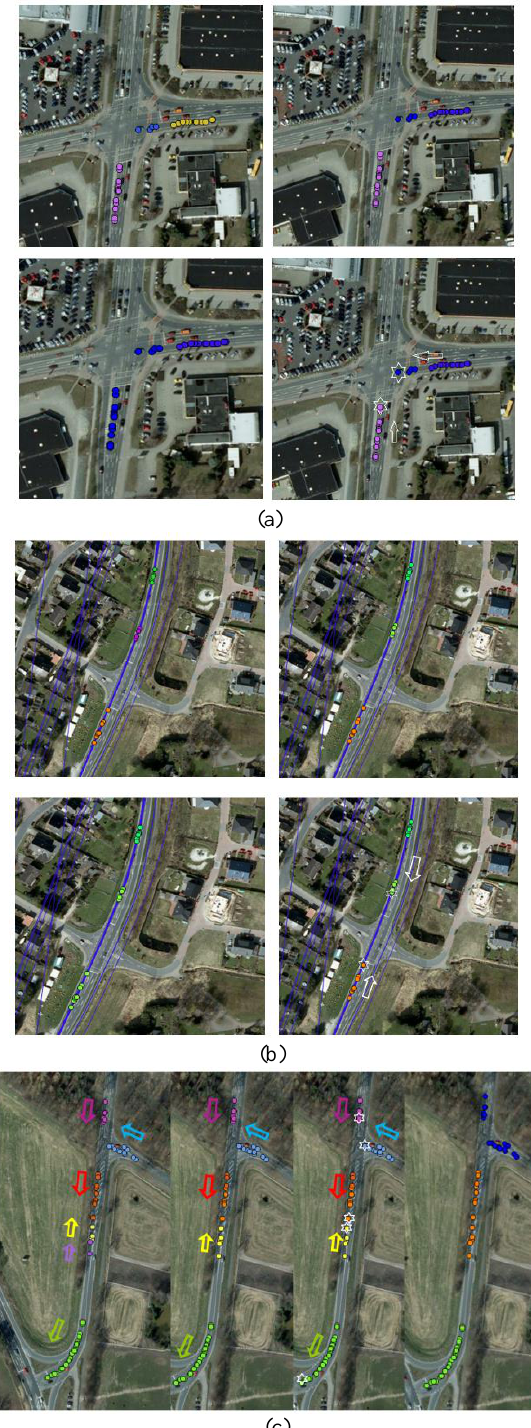
Figure 10. Clockwise from upper-left (a-b) and from left to right(c): clusters found with DBSCAN, merging of similar direction close clusters and determination of representative points (six-pointed stars), region-based clustering using relational reasoning suggests the existence of an intersection (in (c) two